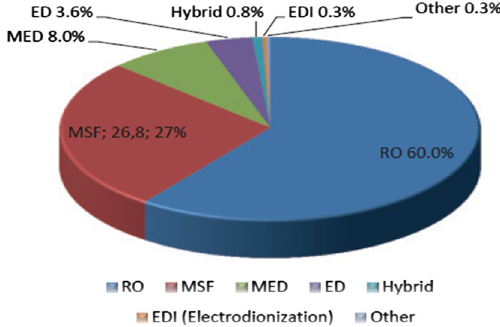
Fig. 4 Trend of increasing use of RO compared to distillation pro- cesses